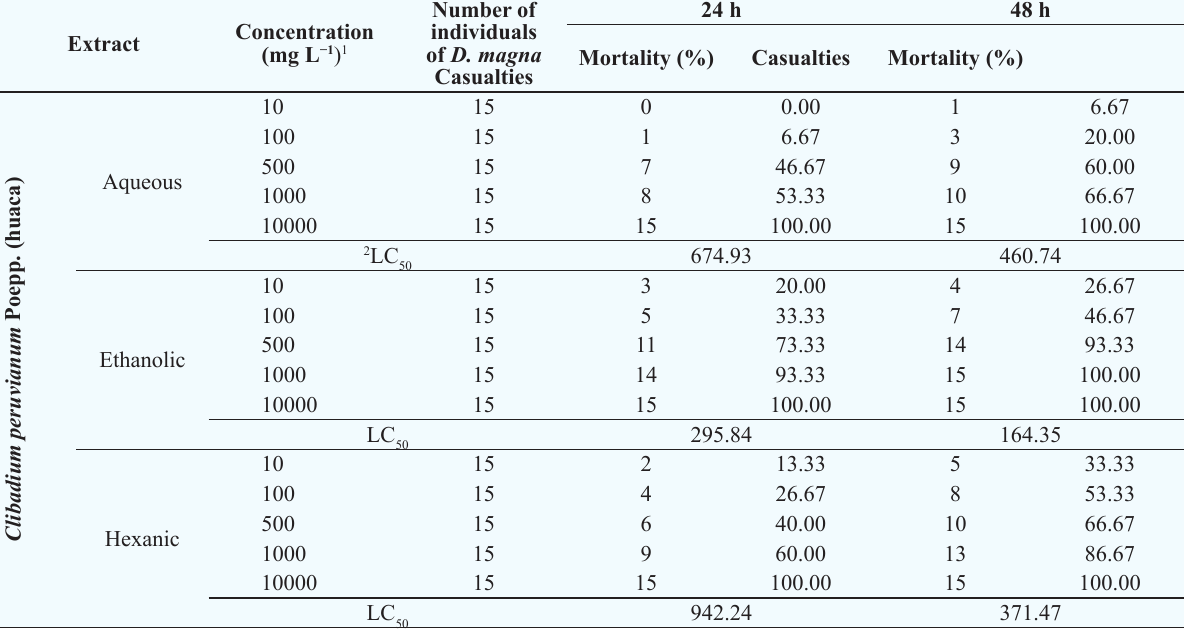
Table 1. Toxic effect of Clibadium peruvianum Poepp. (huaca) extracts in terms of mortality of Daphnia magna during 24 and 48 h of exposure. Extract